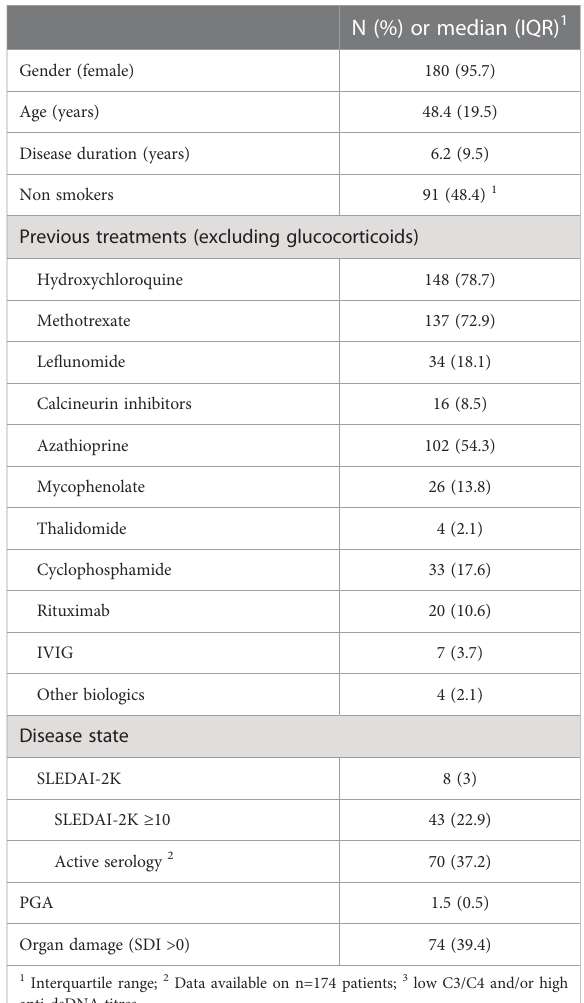
TABLE 1 Baseline demographic and clinical characteristics of SLE patients treated with